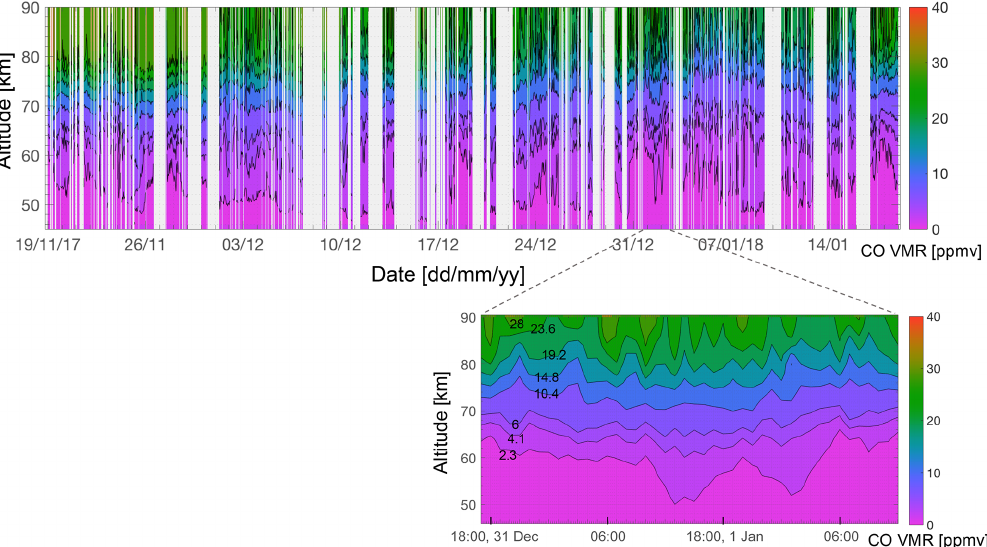
Figure 8. CORAM CO profiles at 1h resolution from mid-November 2017 to mid-January 2018. Blank areas are gaps in the data record. The zoomed-in plot shows measurements over a 43h period beginning at 18:00UTC on 31 December 2017. The isoluminant colour map from Kindlmann et al. (2002) is used. Contour values are [0.4, 2.3, 4.1, 6.0, 10.4, 14.8, 19.2, 23.6, 28.0], chosen and filled for readability. Gaps in the data record correspond to periods of non-operation or bad measurement